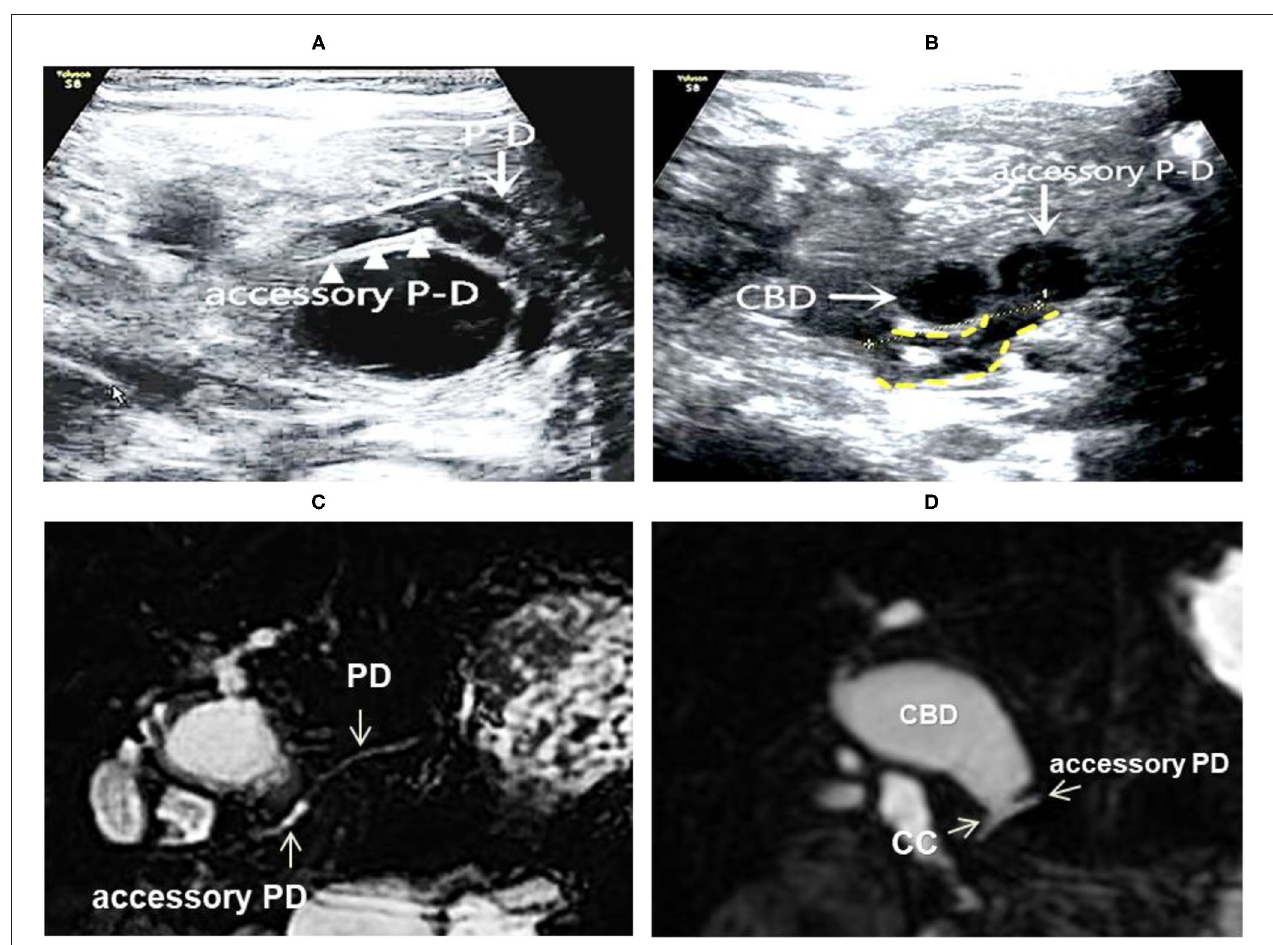
FIGURE 4 | Images of a representative type C of PBM. (A) US transverses scan showing the main PD merging into the dilated accessory PD; (B) US transverse scan showing the terminal CBD and the accessory PD joining downward to form the common channel (shown by yellow dotted lines); (C) MRCP indicated the main PD imports to the accessary PD; (D) MRCP indicated the accessary PD joins with the distal CBD to form the common channel, suggesting a type D.